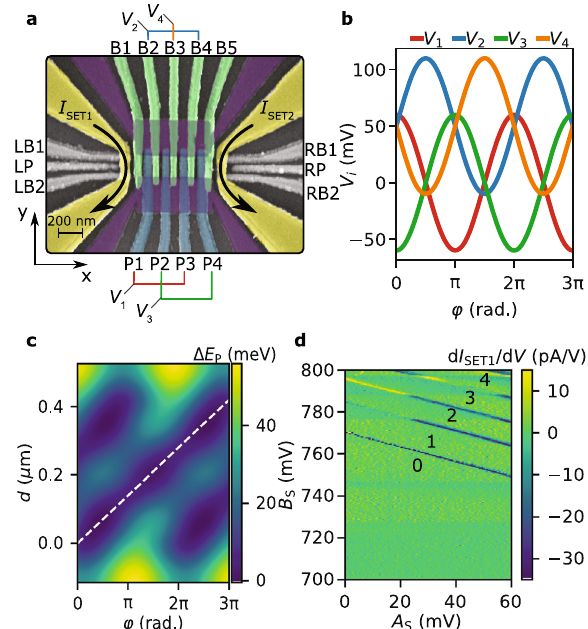
Fig. 1 Device layout and shuttling pulse. a Colored scanning electron micrograph (SEM) of the three-gate layer design used for the device. Lines indicate electrical connections among clavier gates labeled B i and P i . V i ( t ) labels the voltage signal trace applied to electrically connected gate sets. The accumulation gate of each SET is marked in yellow. b Voltage traces V i ( t ) applied to the electrically connected gate sets as indicated in panel a during electron shuttling plotted as a function of φ ( t ) where we here set A S = 60 mV, B S = 0 V and Δ B S = 50 mV. c Electrostatic simulation of the potential difference Δ E p in the strained Si quantum well underneath the clavier gates, if only the voltages V i ( t ) applied to the clavier gates according to b are taken into account. The position of the shuttled QD is indicated by a dotted white line. The simulation uses an offset Δ B S between the gate layers of 50 mV, a shuttling amplitude A S of 60 mV and a Voltage of − 150 mV is applied to the screening gates. d Charge diagram where the amplitude of the shuttling pulse is varied on the x -axis and the total voltage offset on the channel gates is changed along the y -axis. The numbers in the image indicate the electron fi lling at that fabricated on top of a planar Si/SiGe heterostructure (see Methods for details). The long screening gates in the lowest metal layer (colored purple in Fig. 1a) are kept at 0 V throughout the entire measurement and form a one-dimensional electron channel (1DEC) along the x-direction in the Si/SiGe quantum well. At each end of the 1DEC, a single electron transistor (SET) is induced by accumulation gates (colored yellow, purple in Fig. 1a), barrier gates (LB1, LB2, RB1, RB2) and plunger gates (LP and RP). The SET serves a dual purpose as proximal charge detector and electron reservoir tunnel-coupled to the 1DEC. The B and P gates on top of the 1DEC could form up to four QDs (barriers B i , plungers P i ), but here they are used to create a traveling wave-shaped potential in the 1DEC and are referred to as the clavier gates. The same voltages are applied to each fourth gate as indicated by the labels V 1 , V 2 , V 3 and V 4 in Fig. 1a. The gates B 1 and B 5 are each connected separately to control the tunnel barrier between each end of the 1DEC and the SET. For shuttling, we apply a simple sine voltage to the clavier gates (Fig. 1b): where i = 1 … 4 and the phase is given by φ ( t ) = 2 π f ⋅ t with f and t being the shuttling frequency and shuttling time, respectively. A S is the common amplitude of the sine waves, B S and Δ B S are the dc